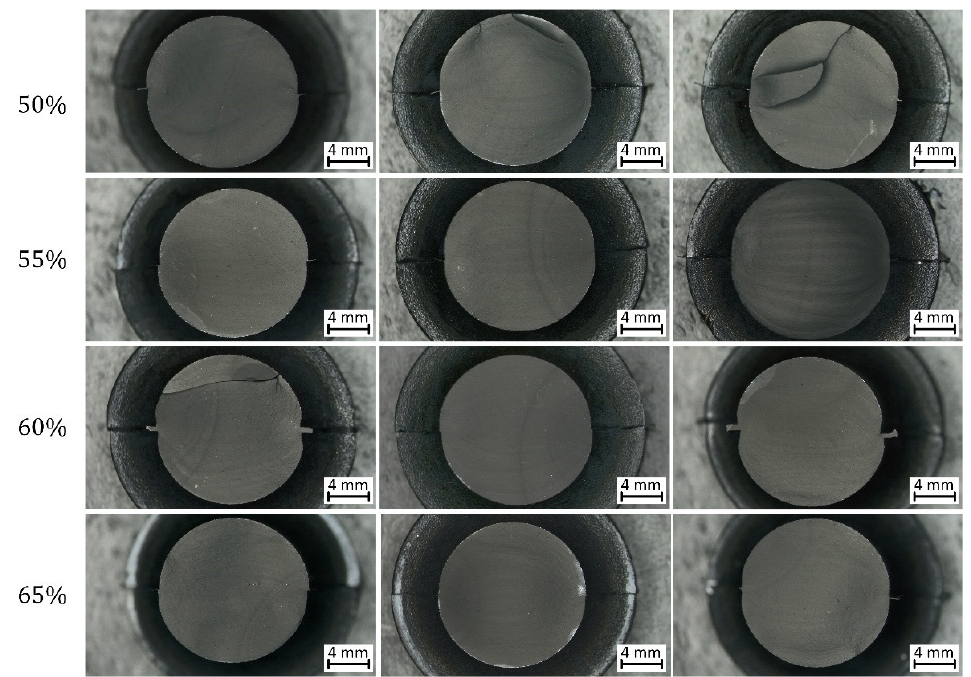
Figure 10. Light microscope pictures of fracture surfaces of axisymmetric dumbbell specimens of CB with NBR at different strains (the correspondent maximum strain is reported on the left). The tests were performed at a frequency of 4 Hz and a load ratio R ε of 0.5.